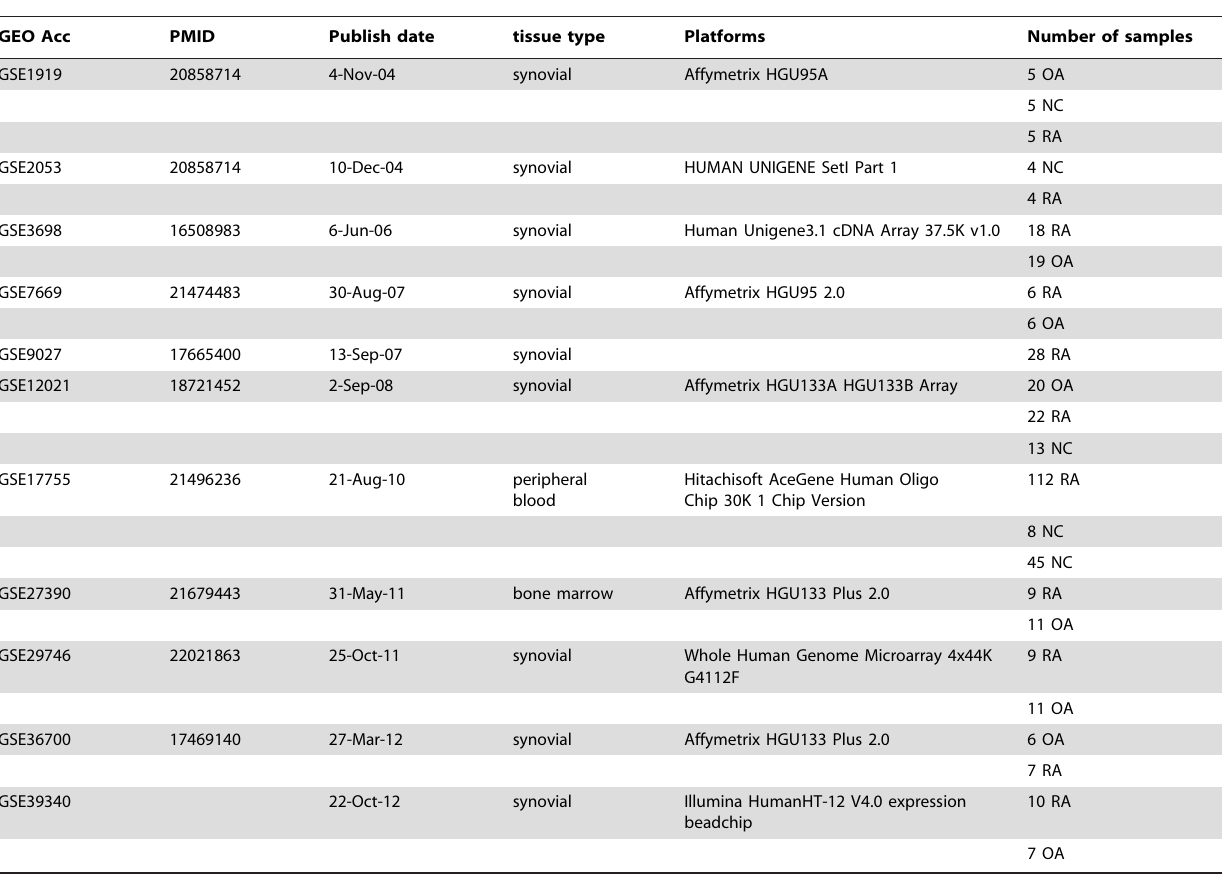
Table 1. Characteristics of analyzed